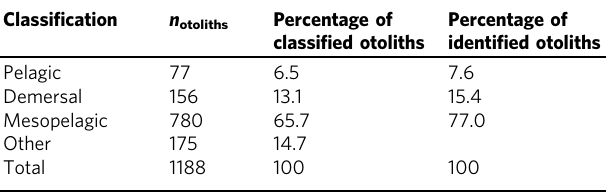
Pelagic are Engraulidae. Demersal are Merlucciidae and Sebastidae. Mesopelagic are BathylagidaeandMyctophidae.Otherareotolithsunabletobeclassi fi edtofamily.Otolithsfrom all cores (KC1, KC2, KC4, and BC1) have been combined. Highly altered otoliths have been excluded ( n otoliths = 336) (see Methods section). Source data are provided as a Source Data fi